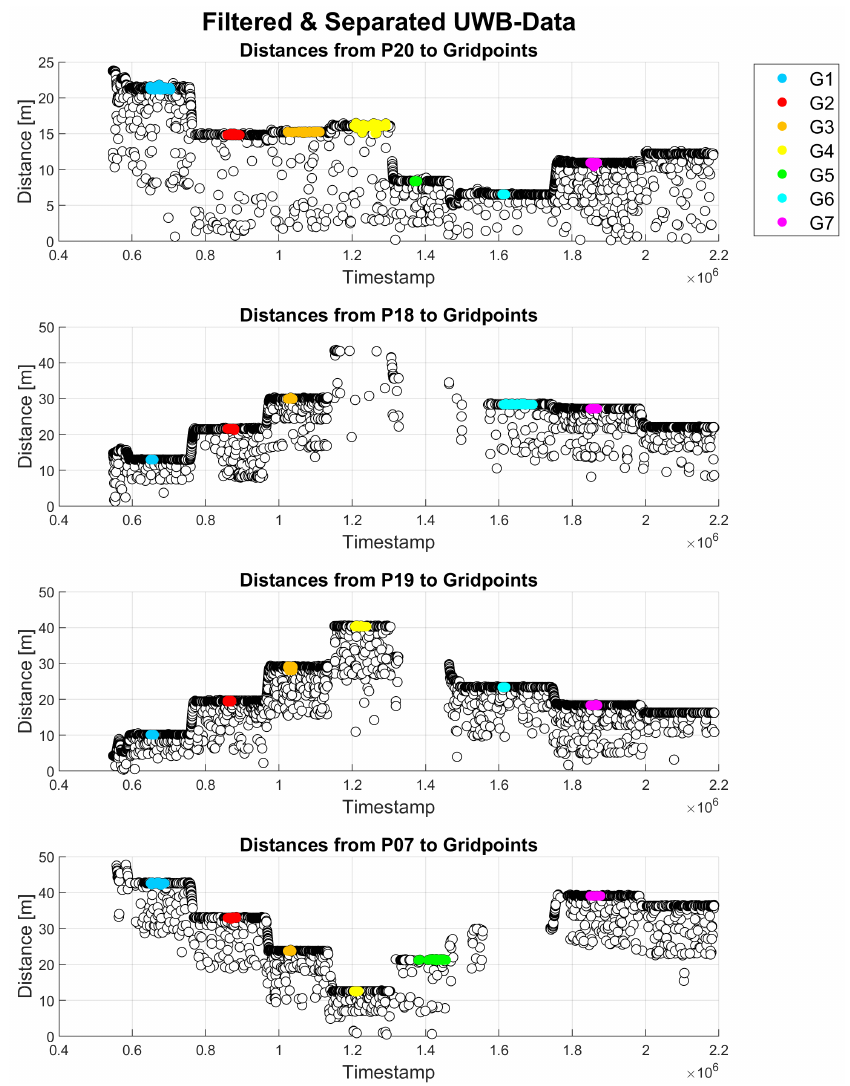
Figure 11. UWB range measurement between anchor points (P20, P18, P19 and P07) and all grid points as indicated in the legend. Table 1. Measured UWB range errors in relation to the ground truth in (m). GP